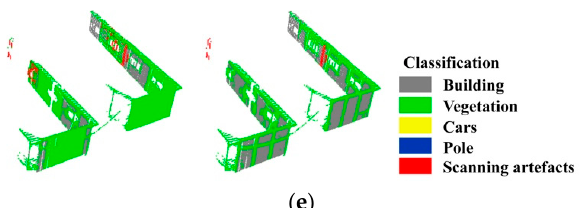
Figure 15. Comparison of the classification results obtained by traditional projection density and relative projection density. The left diagram in each sub-diagram represents traditional projection density and the right diagram in each sub-diagram represents relative projection density. ( a ) poles, ( b ) scanning artifacts, ( c ) cars, ( d ) vegetation, ( e ) buildings.